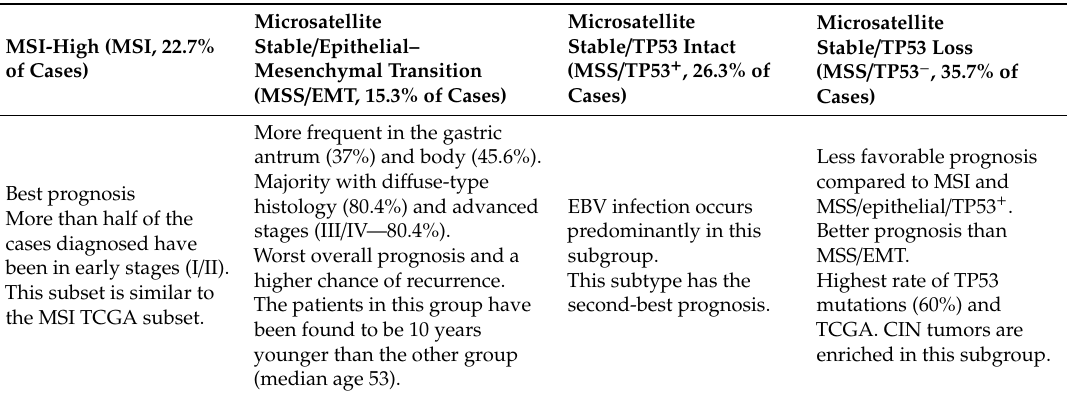
Table 2. Asian Cancer Research Group (ACRG)